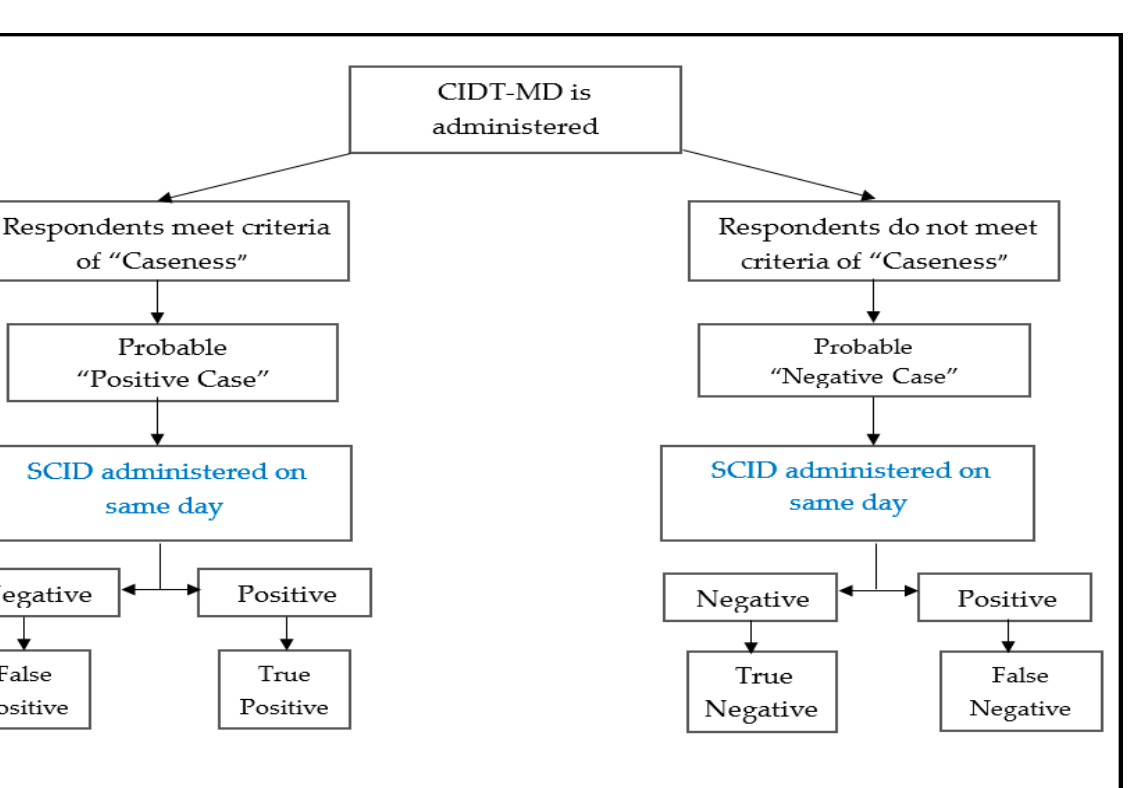
Figure 1. Summary of Detection of Mothers by Community Informants. CIDT-MD is Community Informant Detection Tool for Maternal Depression.